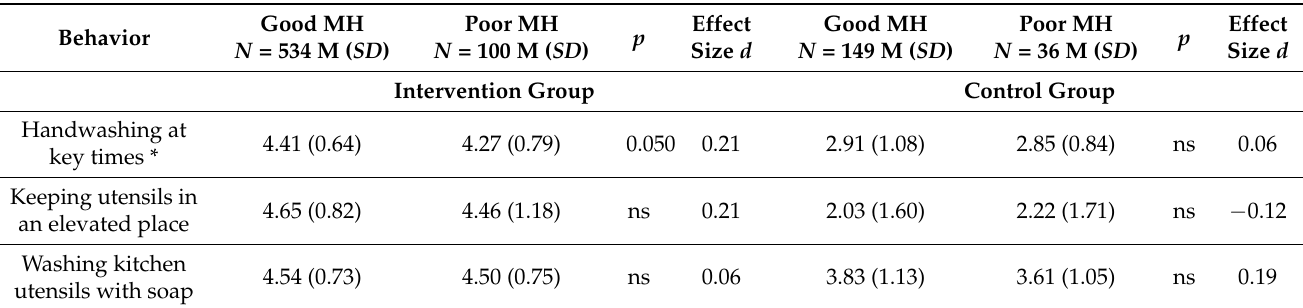
Table 4. Mean comparison of target behaviors on the mental health condition of the study participants: poor versus good in intervention and control group.